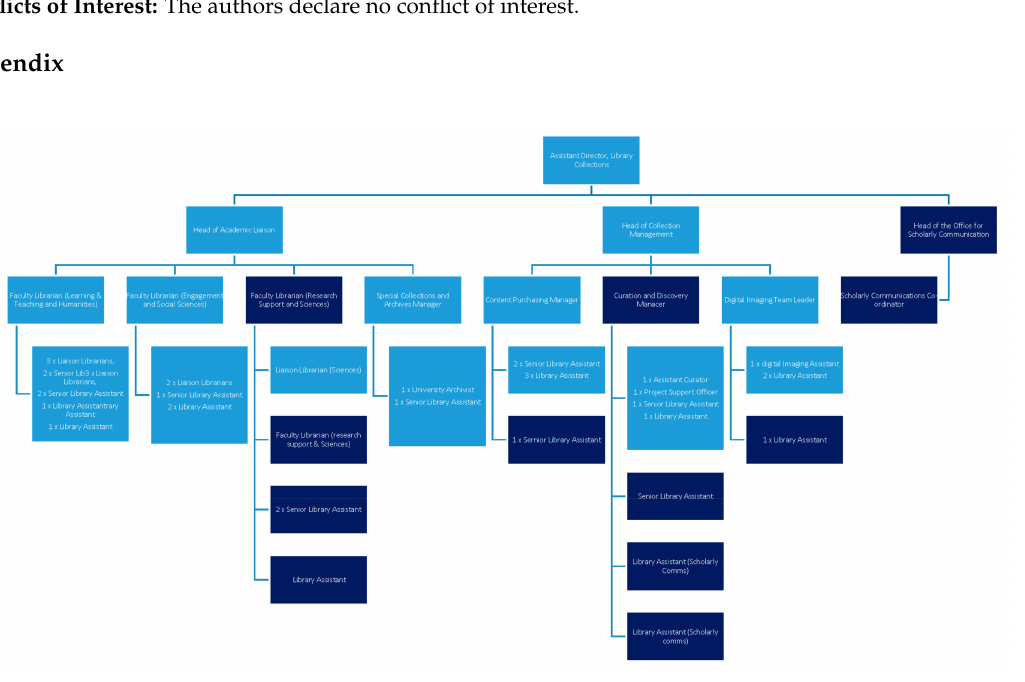
Figure A1. Library Collections—Organisational chart highlighting those involved in Open Access (dark